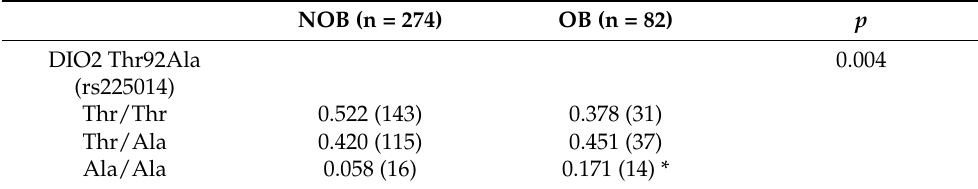
Table 2. Genotype distributions of